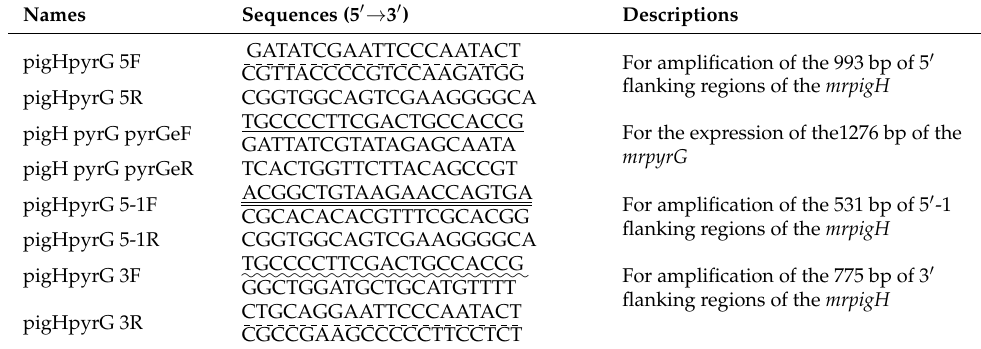
Table 2. Primers used in this